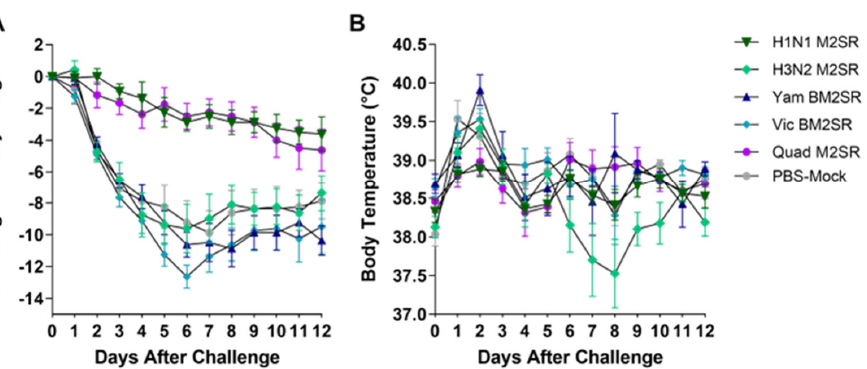
Figure 7. Body weight and temperature changes in M2SR vaccinated ferrets following a challenge with the H1N1 influenza virus. Ferrets were vaccinated with indicated vaccines, as described in Materials and Methods. Six weeks following the final vaccination, ferrets were challenged with the live, wildtype A/California/07/2009 (H1N1 pdm) influenza virus. Body weight ( A ) and temperature ( B ) were monitored for 12 days following the challenge.